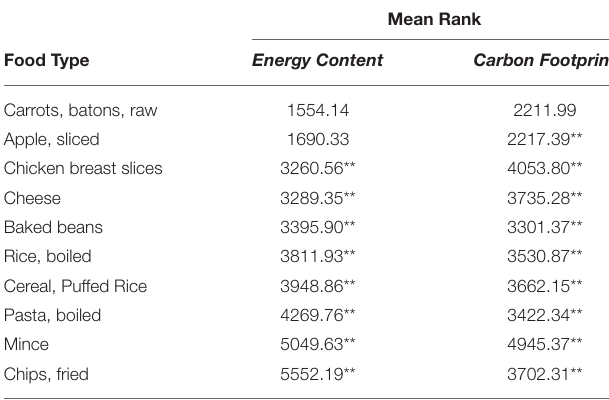
TABLE 3 | Impact of Food Type on Carbon Footprint and Energy Content